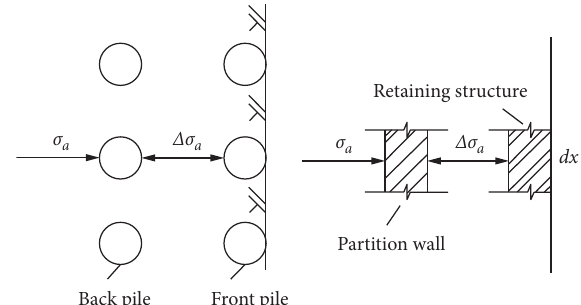
Figure 9: Schematic of the soil-stress comparison.